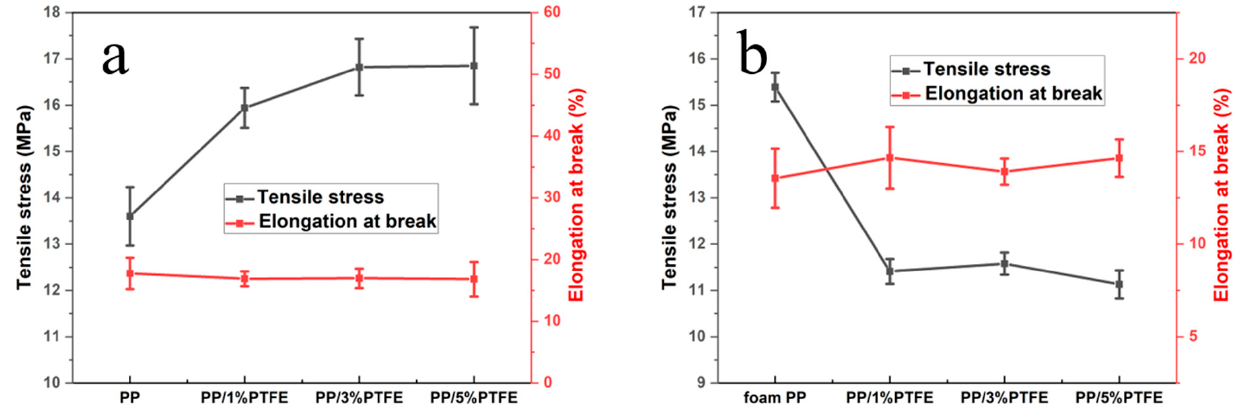
Figure 8. PP and PP/PTFE composite tensile curve before and after foaming ( a ) before foaming; ( b ) after foaming.